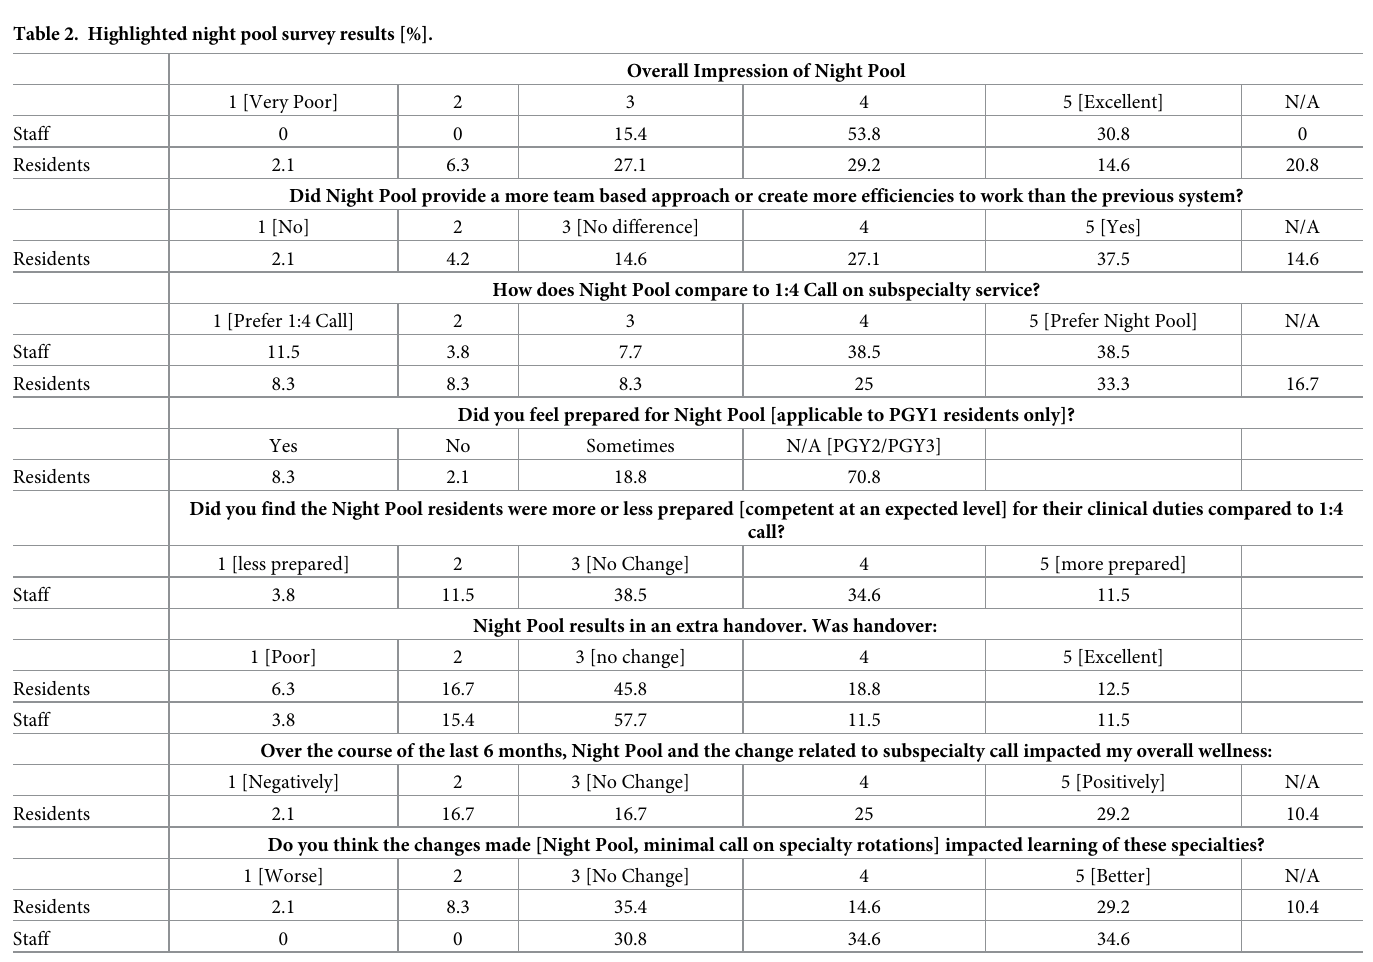
Table 2. Highlighted night pool survey results [%].